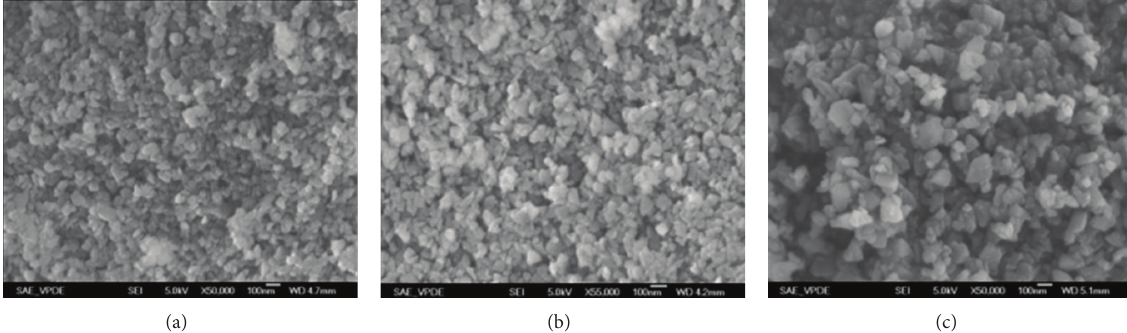
Figure 5: SEM pictures of diamonds. (a) 50 nm diamonds from 1/20, CKK Co., USA ( × 50 K). (b) 70nm diamonds from 1/15, CKK Co., USA. ( × 50K). (c) 100nm diamond from 1/10, CKK Co., USA. ( × 50 K).